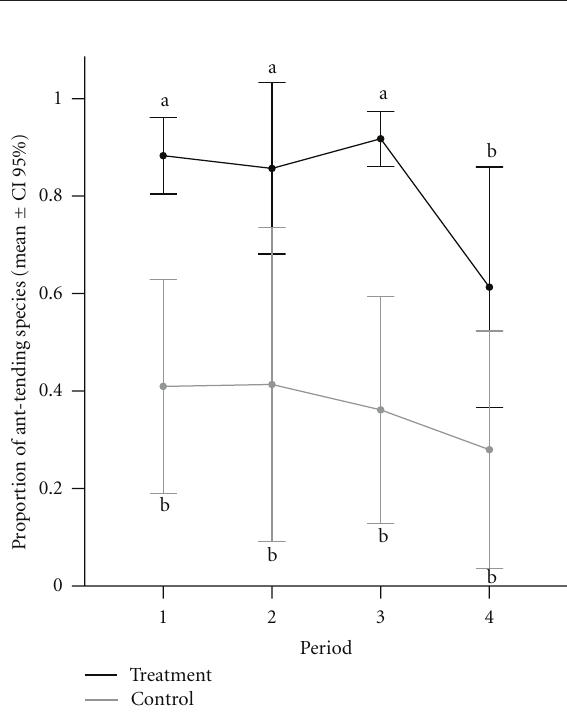
Figure 2: The ant foraging fauna on plants with trophobioses is formed mostly by exudates-feeding species (Repeated ANOVA: F (3;354) = 3.6; P = 0 . 02). Lines show the proportion of the occurrence of trophobiont ant species from total ants. Di ff erent letters indicate significant di ff erences according to post hoc test (LSD: P < 0 .